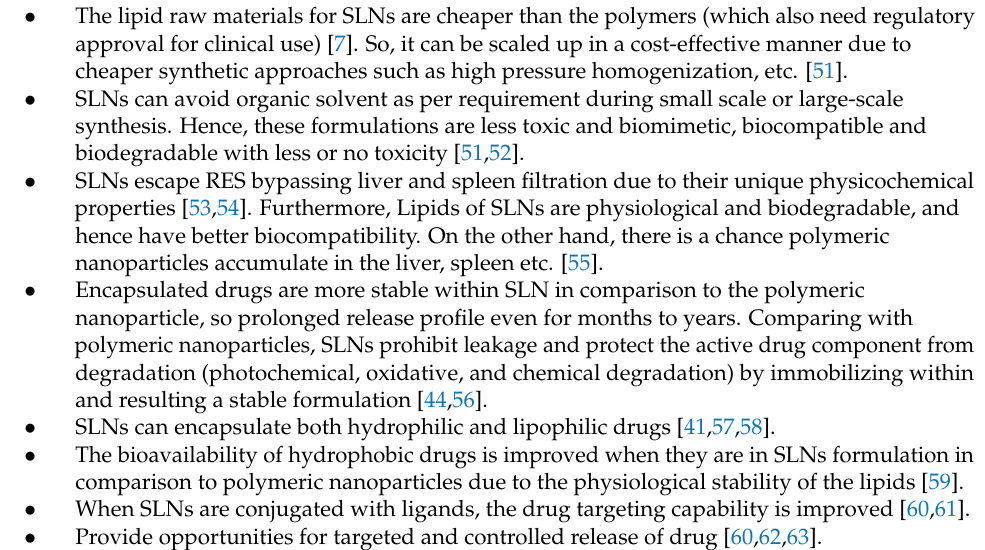
Table 1. Advantages of SLNs over polymeric nanoparticles.